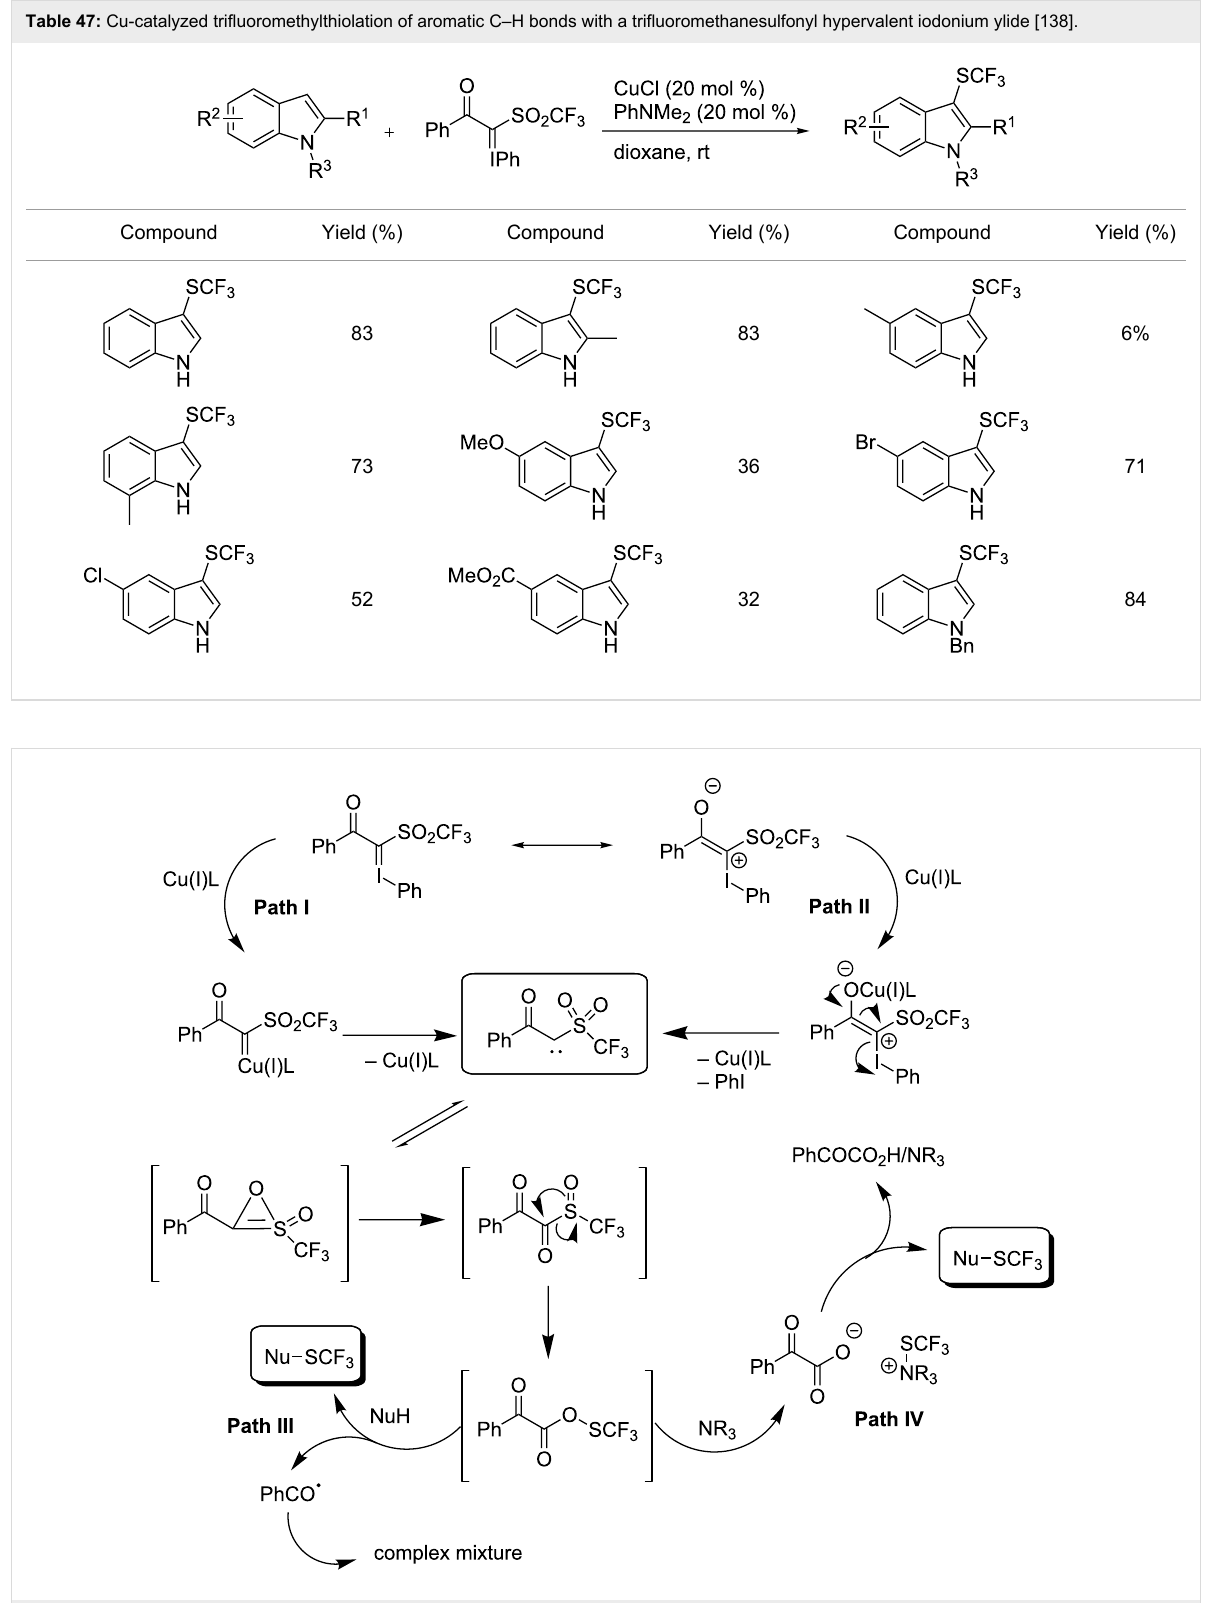
Figure 23: Mechanism of the Cu-catalyzed trifluoromethylthiolation of C–H bonds with a trifluoromethanesulfonyl hypervalent iodonium ylide